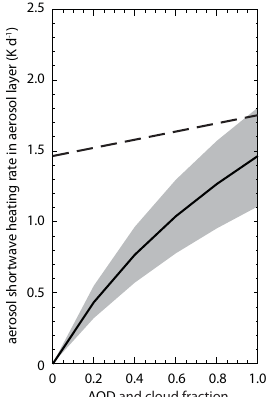
Fig. 4. AIRS atmospheric temperature at the (a) 700hPa pressure level and (b) 600hPa pressure level against AMSR-E sea surface temperature for high smoke and low smoke samples. Air tempera- tures are shown separately for overcast samples only (solid lines), and for all samples (dashed). Vertical bars are the estimated 95% confidence interval based on variability in each SST bin. The dot- ted line in (a) indicates the number distribution of SST values (scale appears on right-hand axis). 2267 samples with OMI AI < 1; 3126 samples with 1 < OMI AI < = 2; 897 samples with OMI AI >